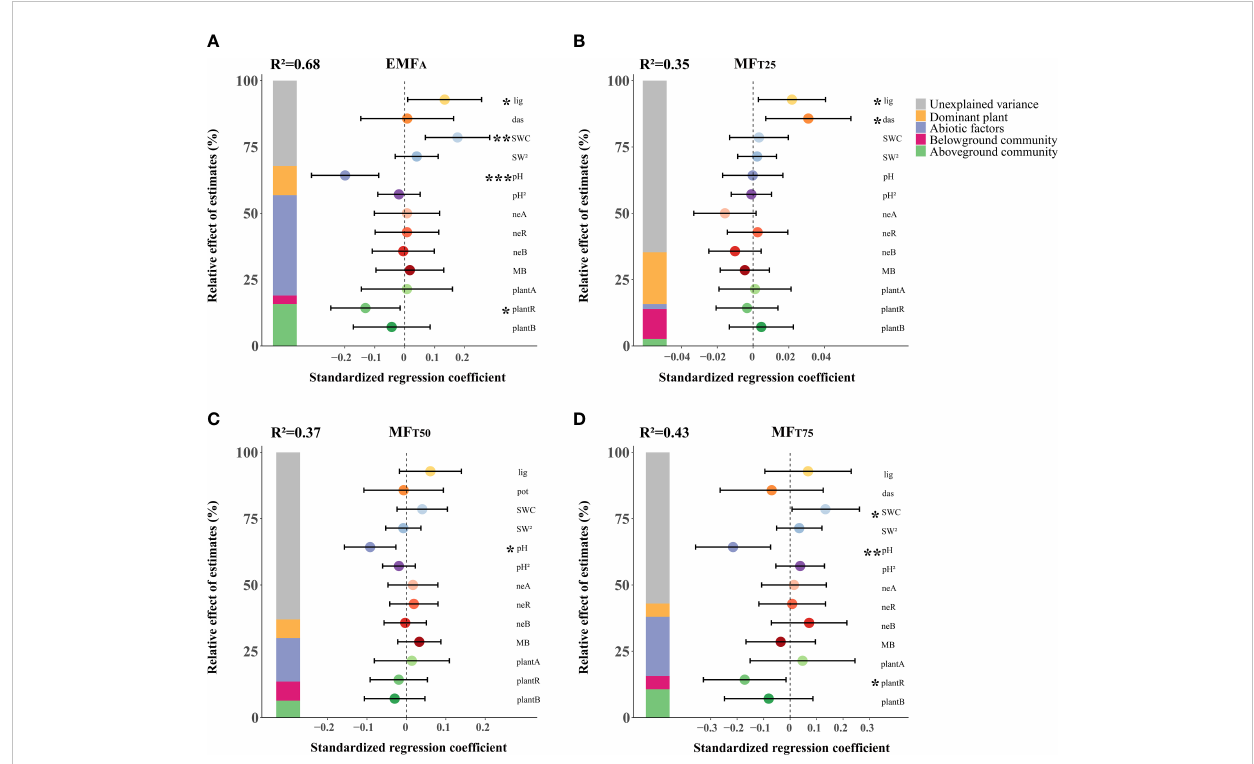
FIGURE 2 The effects of biotic and abiotic factors on EMF A (A) , MF T25 (B) , MF T50 (C) , MF T75 (D) . Standardized regression coef fi cients of model predictors, associated 95% con fi dence intervals and relative importance of each factor, expressed as the percentage of explained variance. The R 2 of the averaged model and the p -value of each predictor are given as: * p < 0.05; ** p < 0.01; *** p < 0.001. lig, L. virgaurea ; das, D. fruticosa ; SWC, soil water content; pH, soil pH; neA, nematode abundance; neR, nematode richness; neB, nematode biomass; MB, microbial biomass; C, N ratio; plantA, plant abundance; plantR, plant richness; plantB, plant